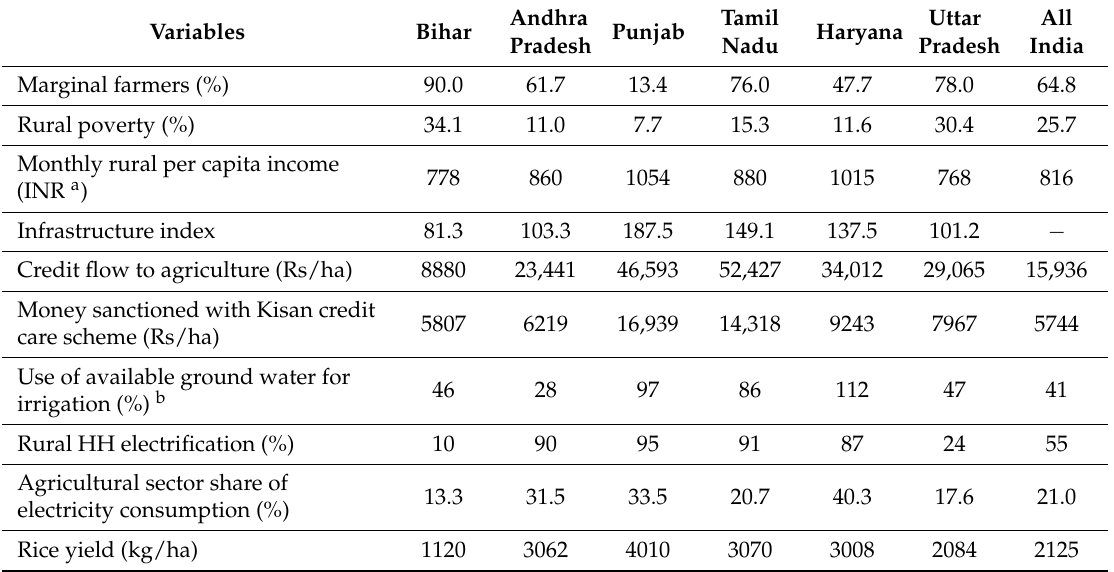
Table 4. Socioeconomy of Bihar in comparison with other major rice growing states in